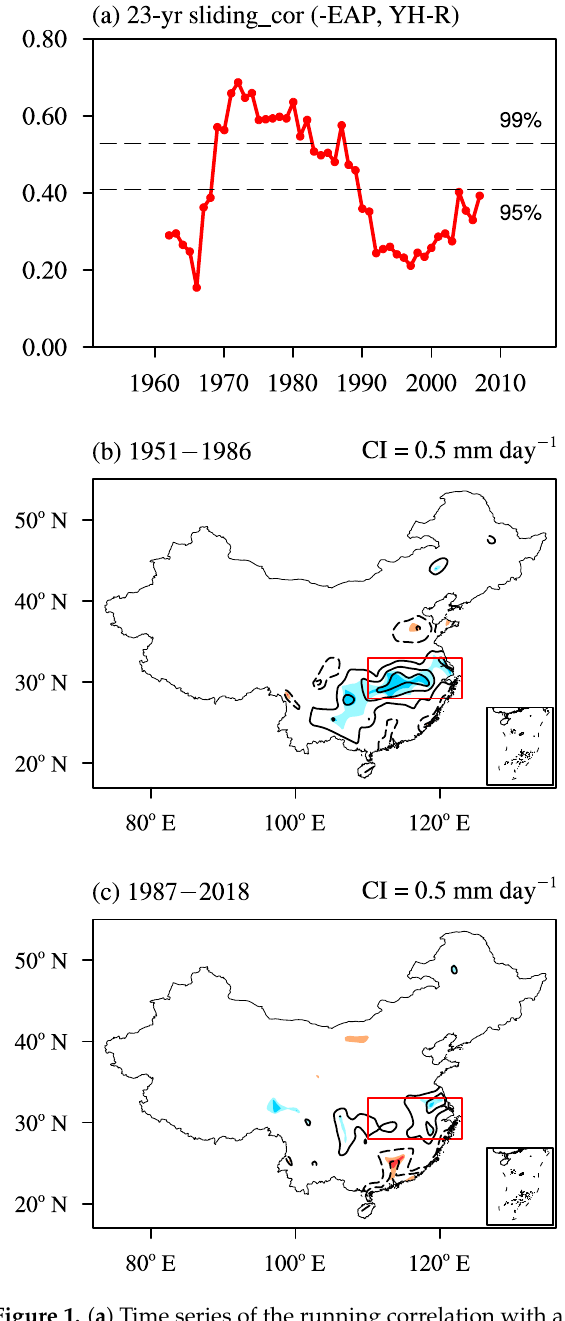
Figure 1. ( a ) Time series of the running correlation with a 23-year window between the EAP index (multiplied by − 1.0) and the normalized JJA rainfall anomalies in the Yangtze River and Huaihe River valley (YH-R; 28–33° N, 110–123° E) during 1951–2018. Regression maps of the JJA rainfall anomalies (contour; unit: mm day − 1 ) in China with respect to the EAP index (multiplied by − 1.0) during ( b ) 1951–1986 and ( c ) 1987–2018. Positive (negative) values are indicated by solid (dashed) contours with the zero contour omitted. The three orange (blue) shadings from shallow to deep indicate that positive (negative) anomalies are significant at the 90%, 95%, and 99% confidence levels based on a two-tailed Student’s t test, respectively. The red boxes in ( b , c ) indicate the YH-R basin.